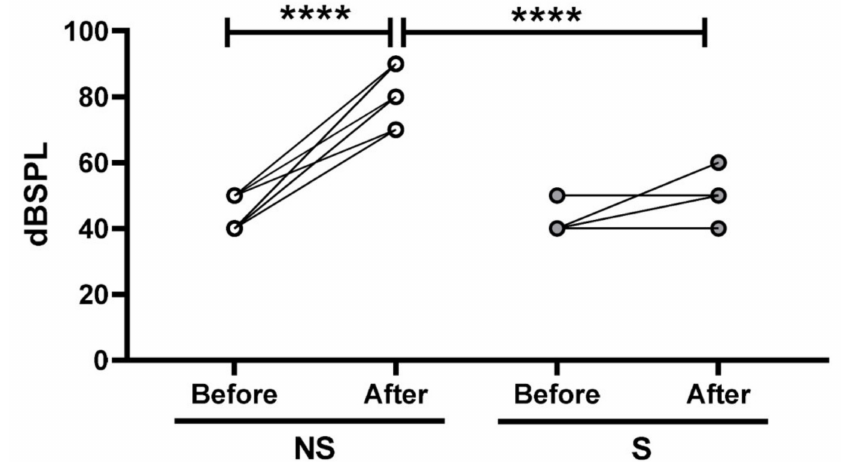
Figure 5. Analysis of the electrophysiological threshold shift (in dBSPL) in the cochleae of rats previously submitted (S, n = 20) or not submitted (NS, scramble, n = 20) to TNF α blockade by gene